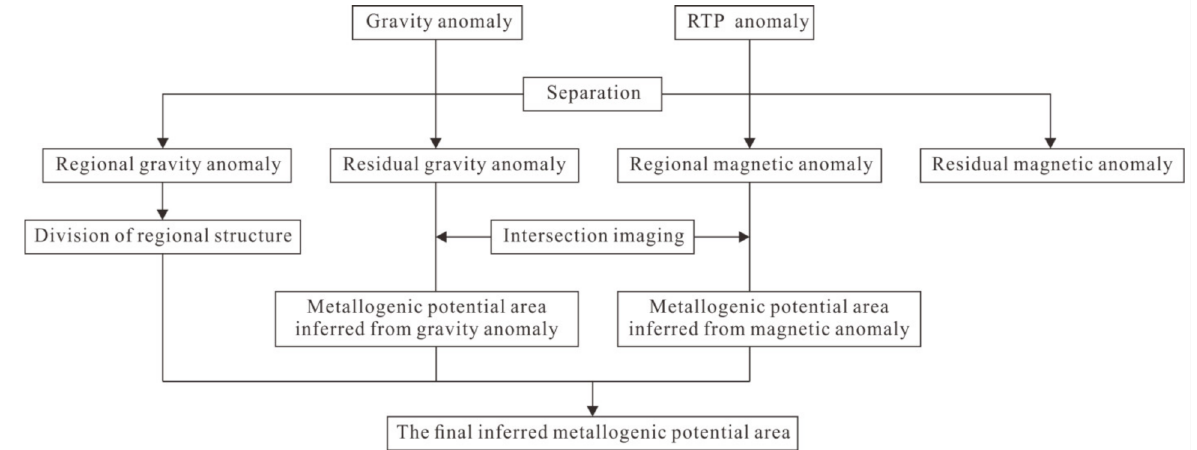
Figure 5. Flow chart of metallogenic potential area delineation.